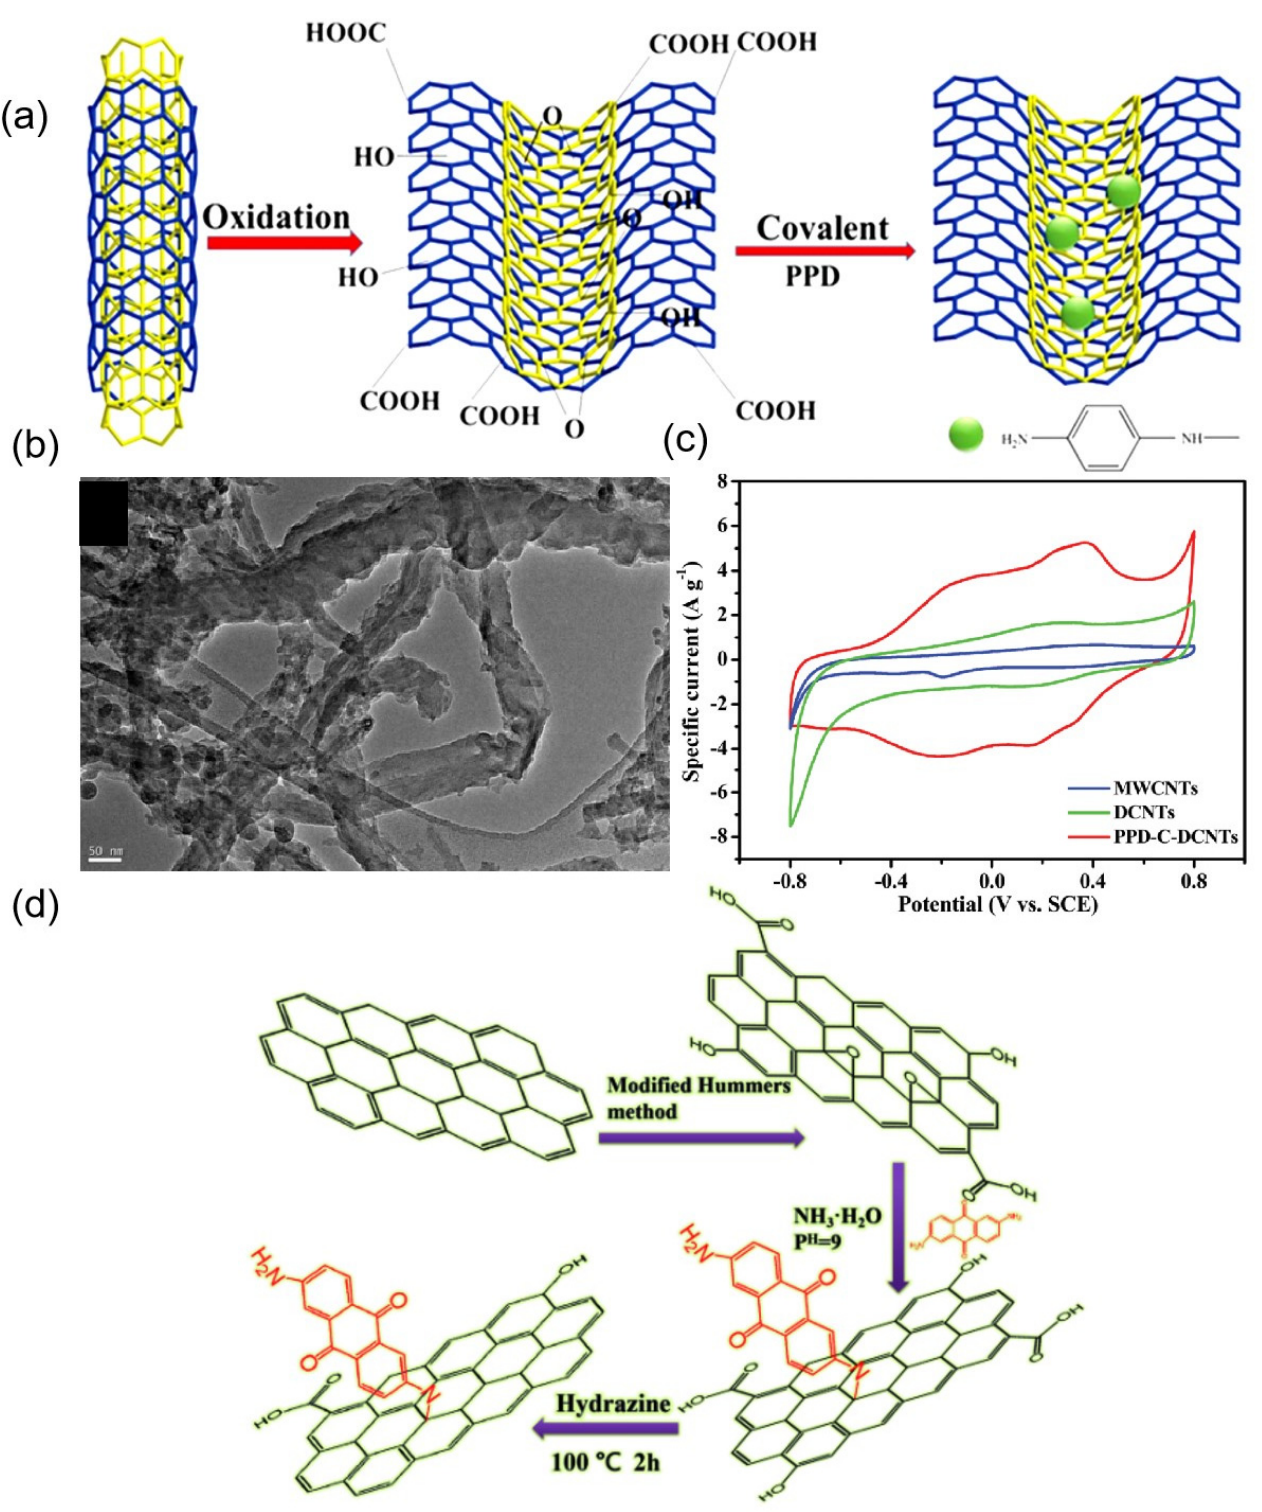
Figure 7. ( a ) Schematic diagram for the synthesis of PPD − C − DCNTs. ( b ) FESEM images of PPD − C − DCNTs. ( c ) CV curves of MWCNTs, DCNTs, and PPD − C − DCNTs, Reproduced from [74] with permission from the Royal Society of Chemistry. ( d ) Schematic illustration of the synthesis of the DQ-RGO. Reproduced from [75] with permission from the Royal Society of Chemistry.